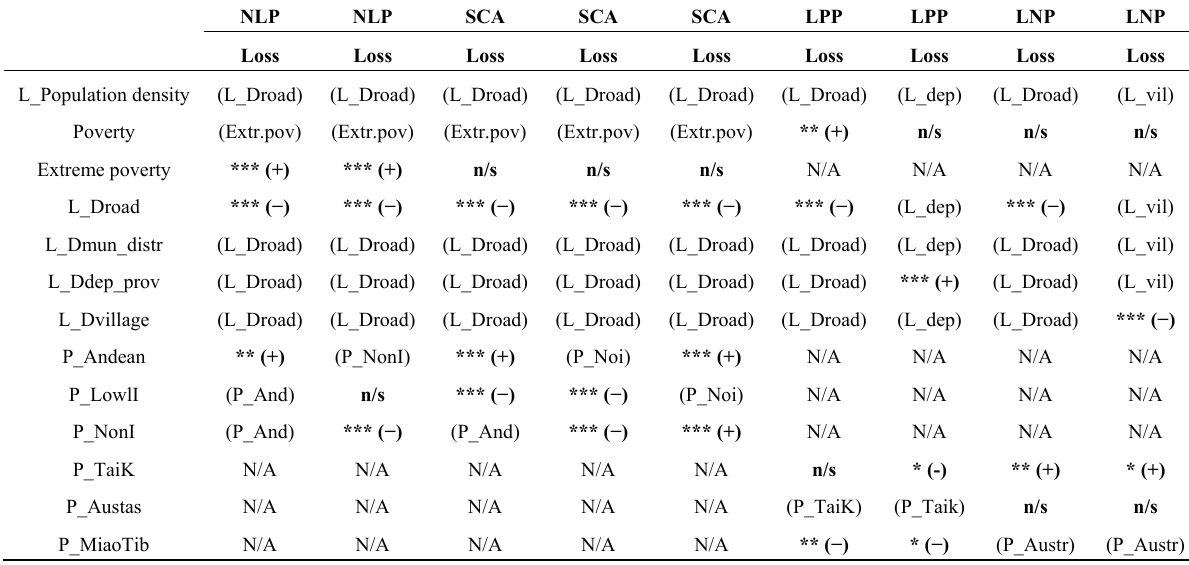
Table 5. Significance of explanatory variables for relative forest loss in the multivariate stepwise regression model.